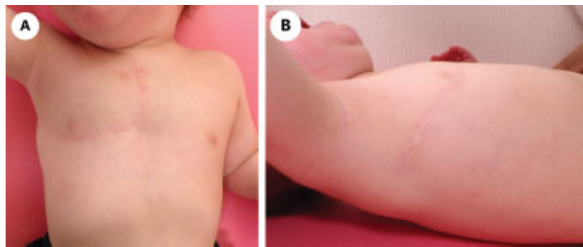
Fig. 2 Cosmetic outcomes. Healing of the hemi-clamshell incision is shown at 1-year postsurgery ( A : frontal view; B : lateral